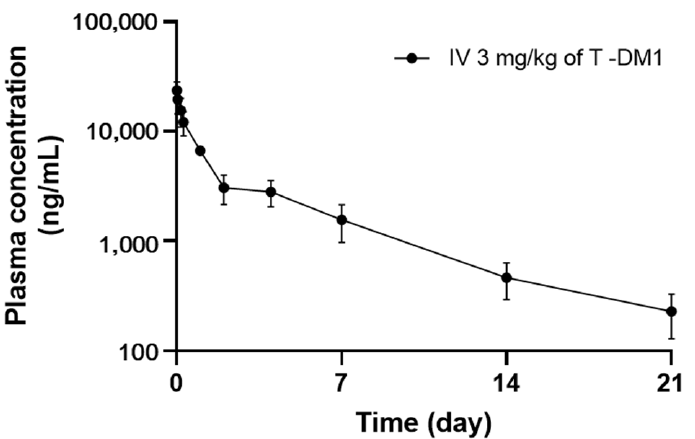
Figure 6. Pharmacokinetic (PK) profile of desulfurated DM1 after intravenous dose of 3 mg/kg for T-DM1 in rats. Table 4. PK parameters of desulfurated DM1 after intravenous dose of 3 mg/kg for T-DM1 in rats. PK Parameters